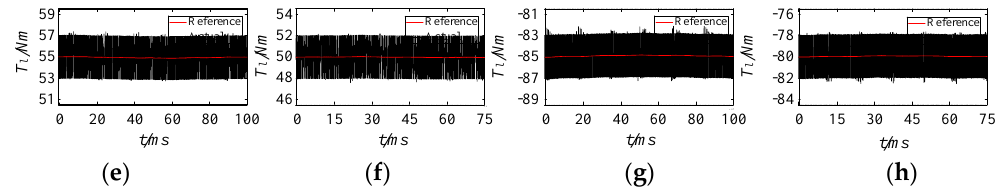
Figure 13. Simulation waveforms of SVDTC. ( a ) 55 Nm, 62.8 rad/s (motoring mode); ( b ) 50 Nm, 100 rad/s (motoring mode); ( c ) −85 Nm, 62.8 rad/s (generating mode); ( d ) −80 Nm, 100 rad/s (generating mode); ( e ) 55 Nm, 62.8 rad/s; ( f ) 50 Nm, 100 rad/s; ( g ) −85 Nm, 62.8 rad/s; ( h ) −80 Nm, 100 rad/s.